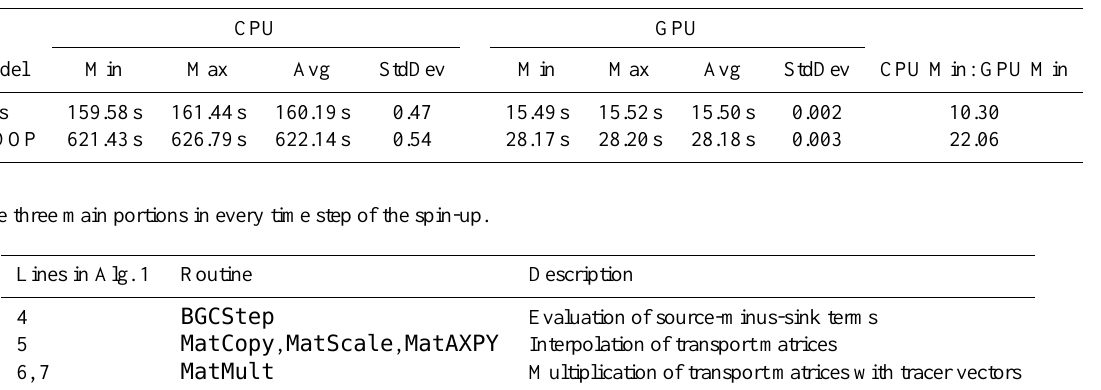
Table 3. Minimum, maximum, average and standard deviation of computational time for one model year spent on the CPU and GPU. Shown are results of 100 model years, each year timed separately. BGCStep block size: 160. CPU